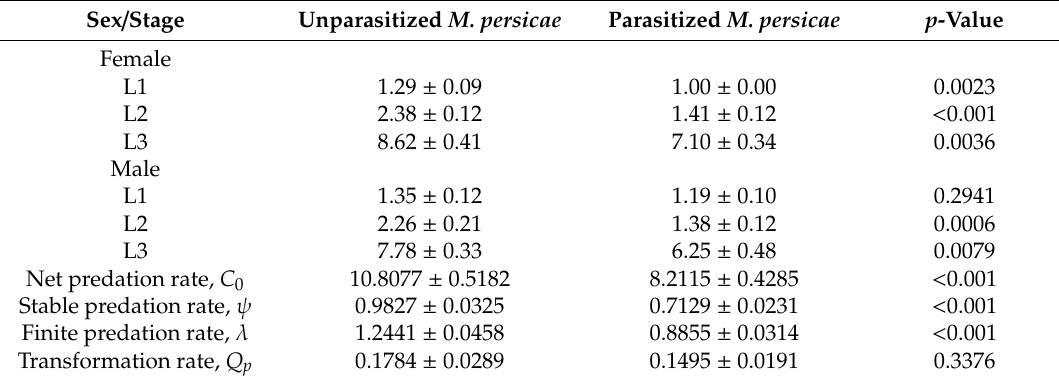
Predation rate (aphids / day) by Aphidoletes aphidimyza and calculated parameters on unparasitized and parasitized Myzus persicae by Aphidius gifuensis . Sex / Stage Unparasitized M.